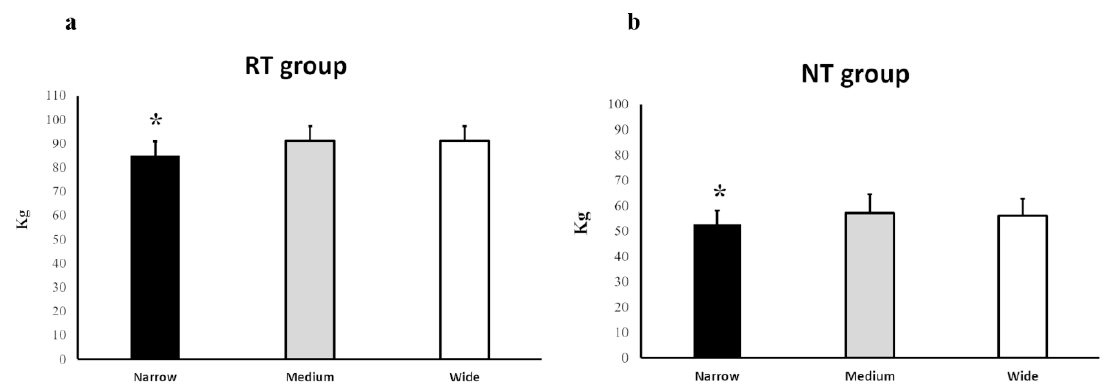
Figure 1. ( a , b ). The mean 6-RM loads (95% CI) in narrow, medium, and wide grip widths for the RT group ( a ) and novice group ( b ). * Significant difference compared to the other grip